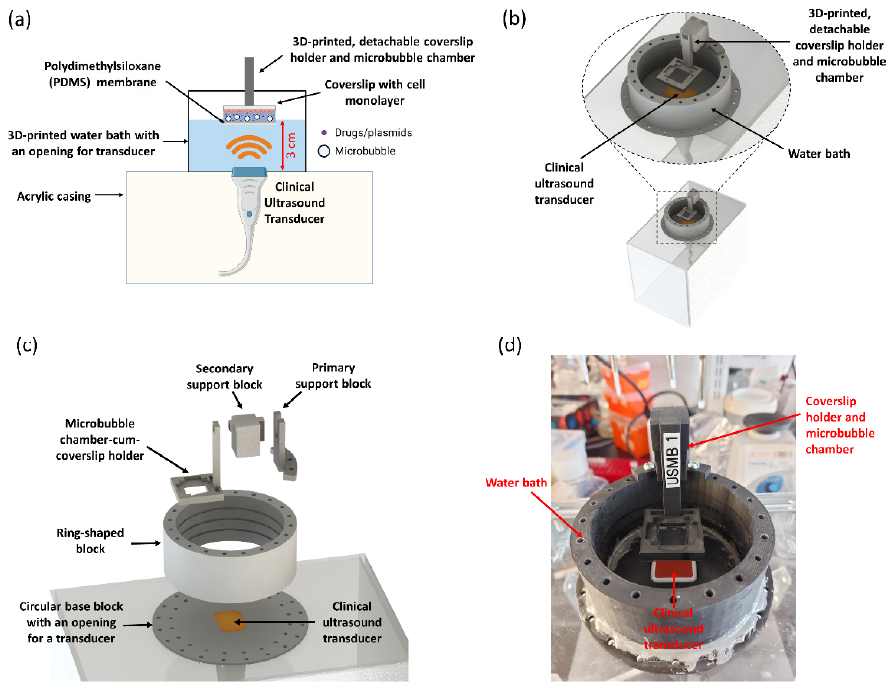
Figure 1. Schematic and 3D CAD model of UMCC platform. ( a ) Schematic diagram of UMCC. ( b ) 3D computer-aided design (CAD) model of UMCC. ( c ) Exploded view of UMCC showing different modular parts that are assembled to form the complete setup. Modularity enables easy customization of the platform. ( d ) Actual image of UMCC prototyped using 3D printing and laser cutting.